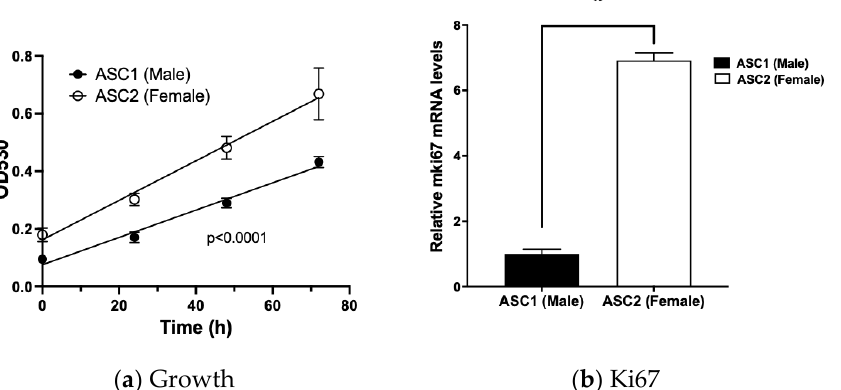
Figure 1. Differential growth characteristics of individual adipose stem cells (ASCs). ( a ) Comparison of ASC growth rates. ASCs were cultured and cell growth determined as described in Materials and Methods using the SRB method. Results are expressed as mean +/ − SD (n = 8). Regression analysis was performed and the two curves were significantly different at p < 0.0001. ( b ) Comparison of proliferation marker Ki67 mRNA levels. ASCs were cultured and proliferation marker Ki67 mRNA levels determined as described in Materials and Methods. Data expressed as relative mRNA levels to ASC1 (Mean +/ − SD, n = 3). * indicates significantly different from each other at p < 0.05.